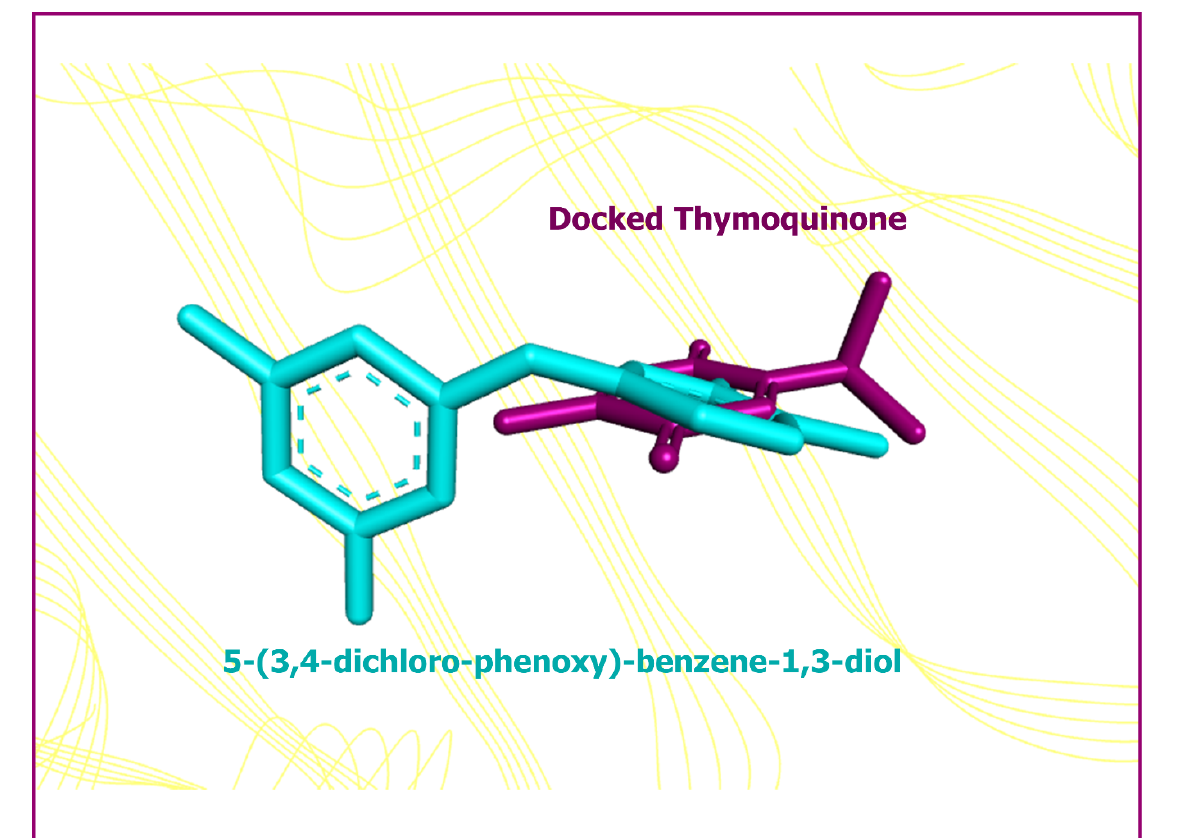
Figure 3. Docked TQ in the binding pocket of phosphatidylinositol-3 kinase alpha, shown in ribbon style ( A ). Ligplot diagram ( B ) showing intermolecular interactions. Hydrogen bond interaction is shown as a broken green line.